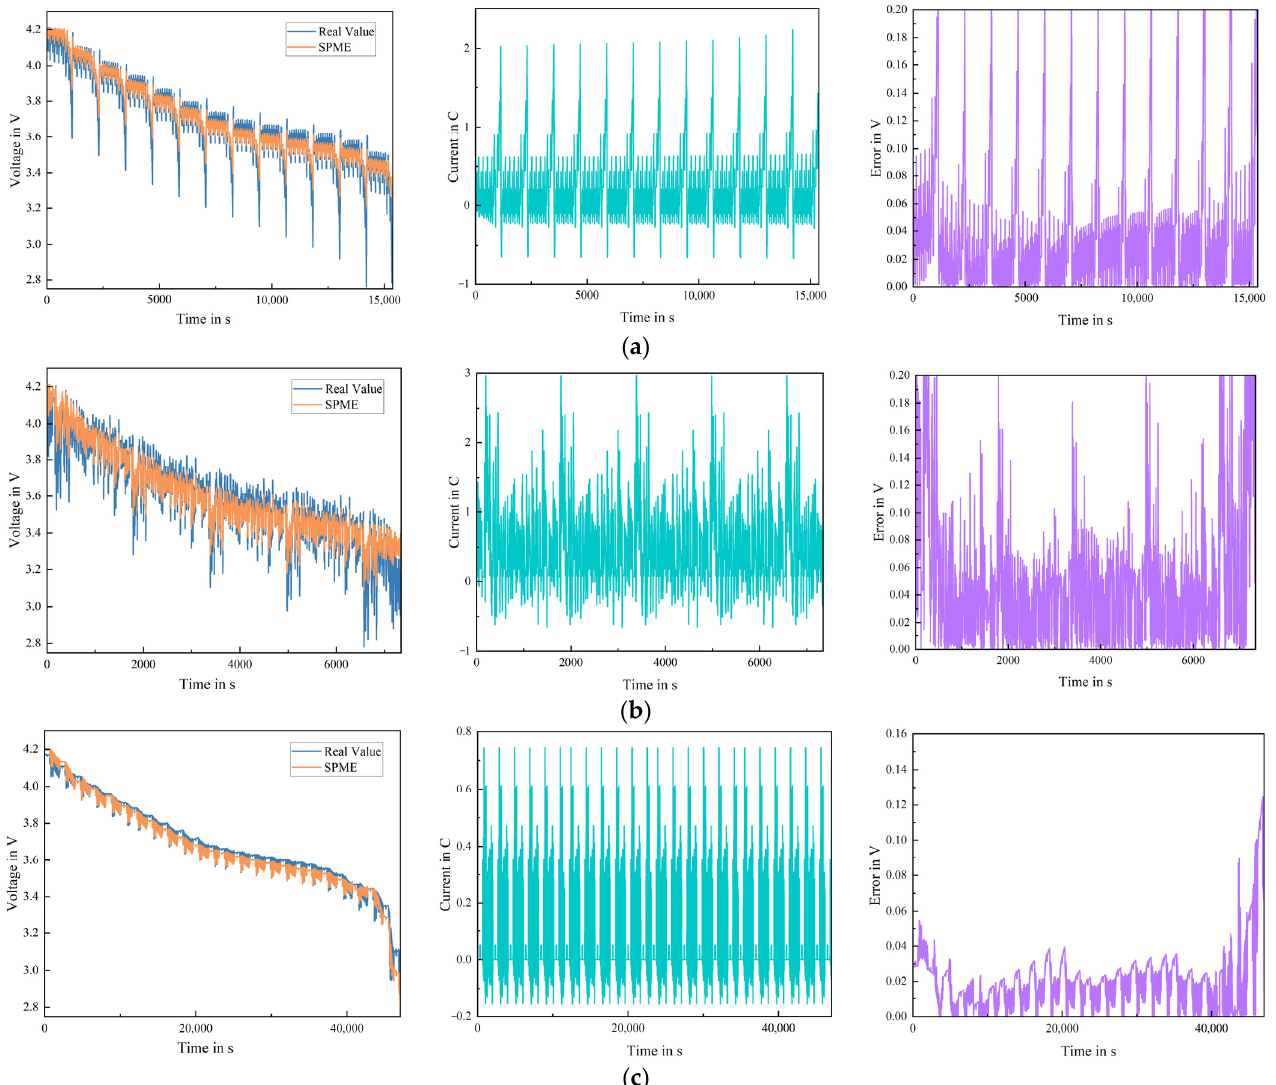
Figure 7. Model simulation results of voltage, current and the voltage error under ( a ) NEDC condi- tions, ( b ) FTP conditions and ( c ) UDDS